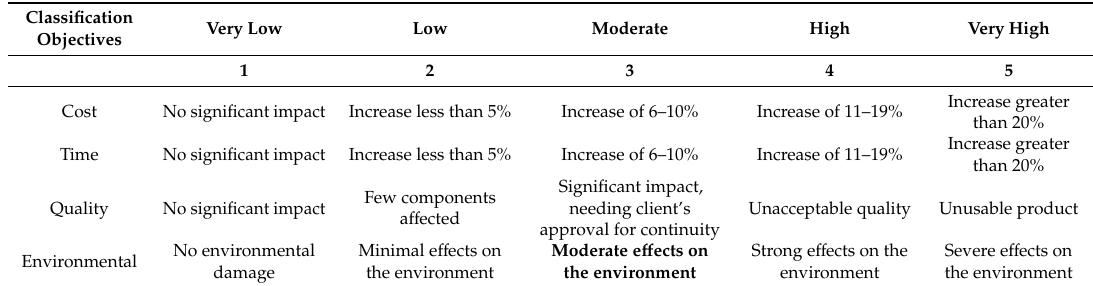
Table 4. Scale of impact.